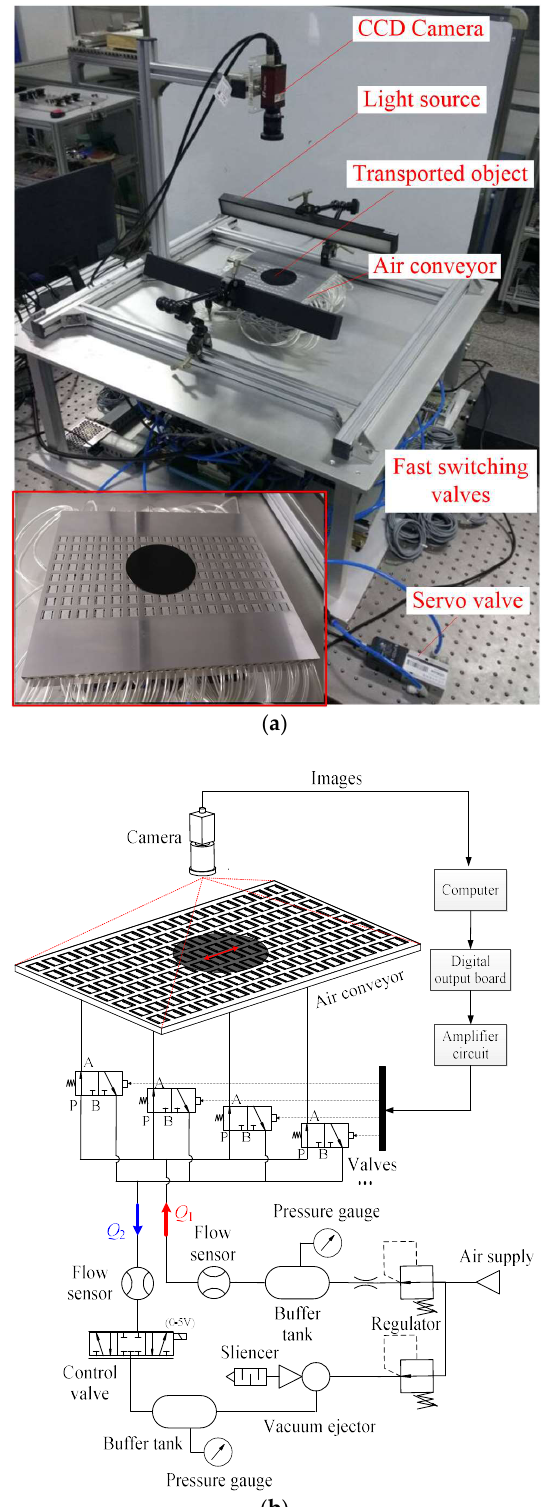
Figure 11. ( a ) Photograph of the experimental setup. ( b ) Air supply circuit.